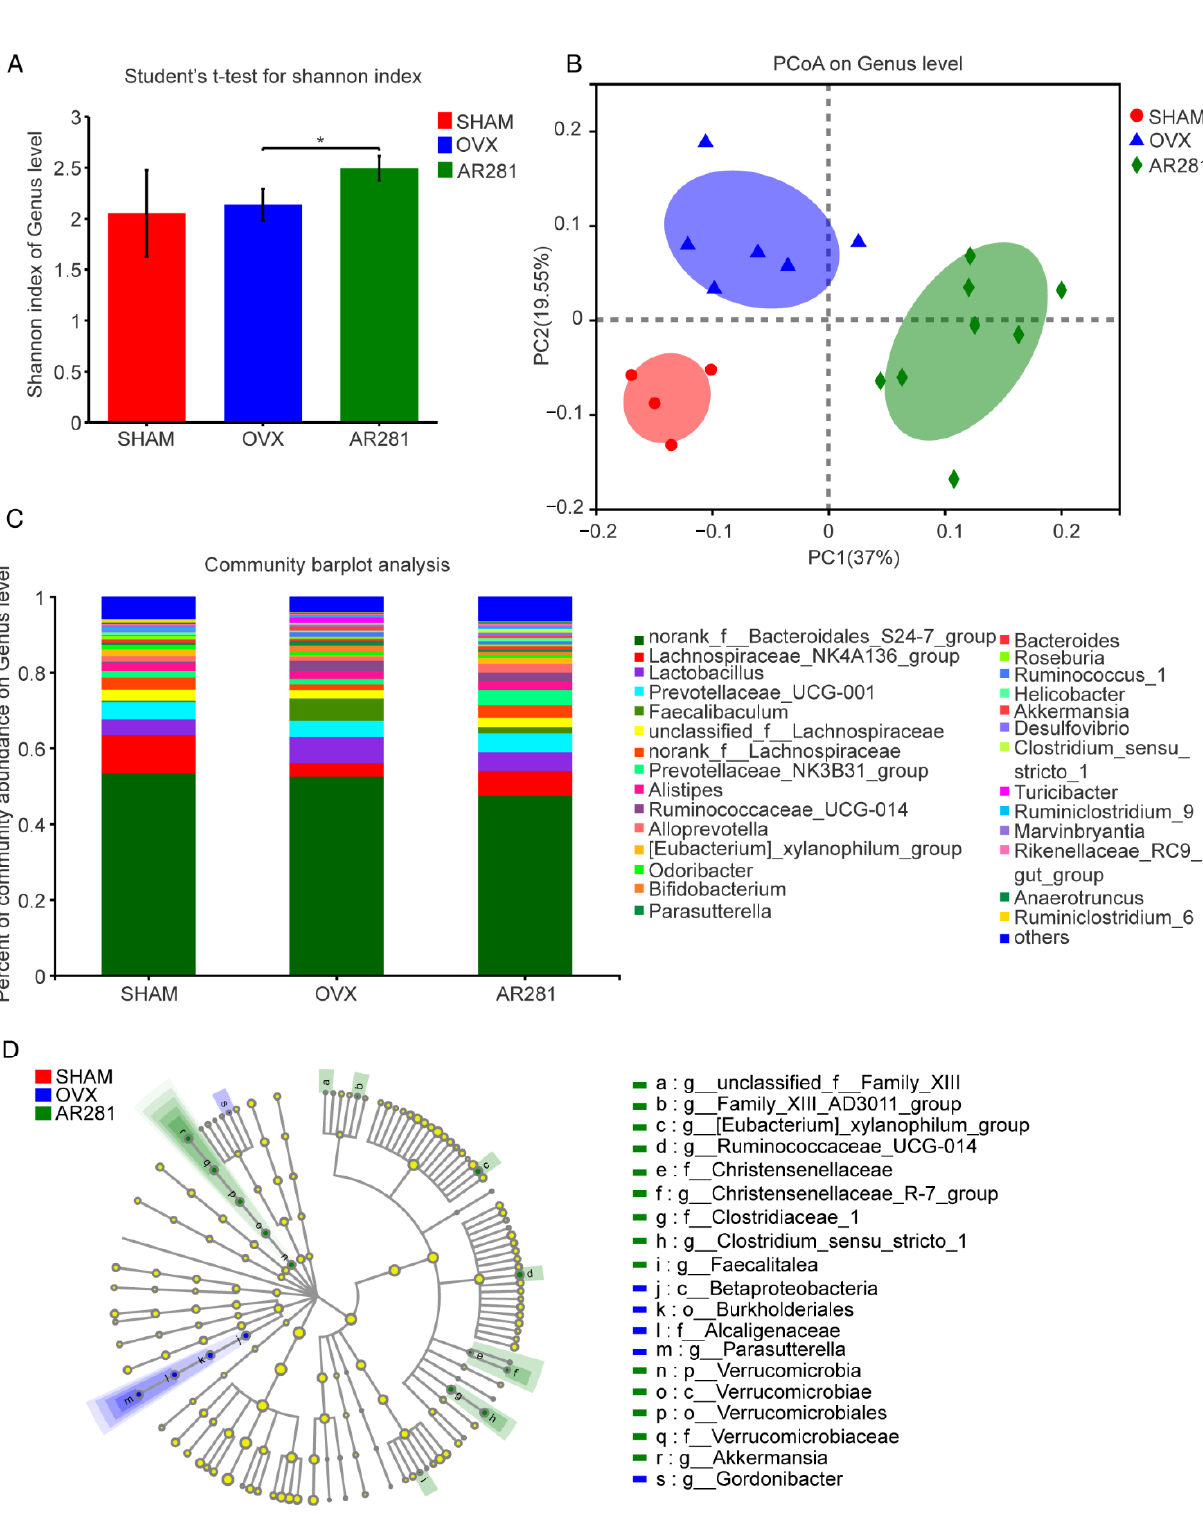
Figure 4. The effects of L. brevis AR281 on intestinal microbial variation: ( A ) Shannon index of the genus level; ( B ) principal coordinates analysis (PCoA) plots of fecal microbial communities based on abundance Jaccard distance; ( C ) community bar-plot analysis of the fecal microbiota; ( D ) linear discriminant analysis effect size (LEfSe) of fecal microbial communities among groups. n = 4, 6, or 8 in SHAM, OVX, or AR281, respectively. * p < 0.05.